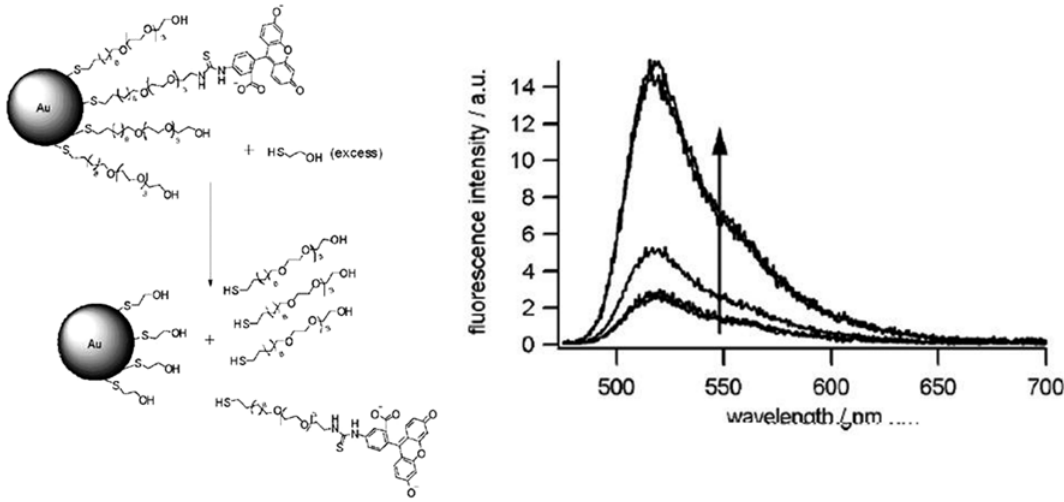
Figure 13: Left: Liberation of bound fluorophores by ligand exchange using a large excess of β -mercaptoethanol. Right: Evolution of the fluorescence intensity ( λ exc = 469 nm) of fluorescently tagged MP-AuNPs upon addition of 4 mm β -mercaptoethanol. The fluorescence intensity increases to reach a new constant value after 33 h (spectra taken before; just after; and at 0.5, 18, 23, and 33 h after addition of